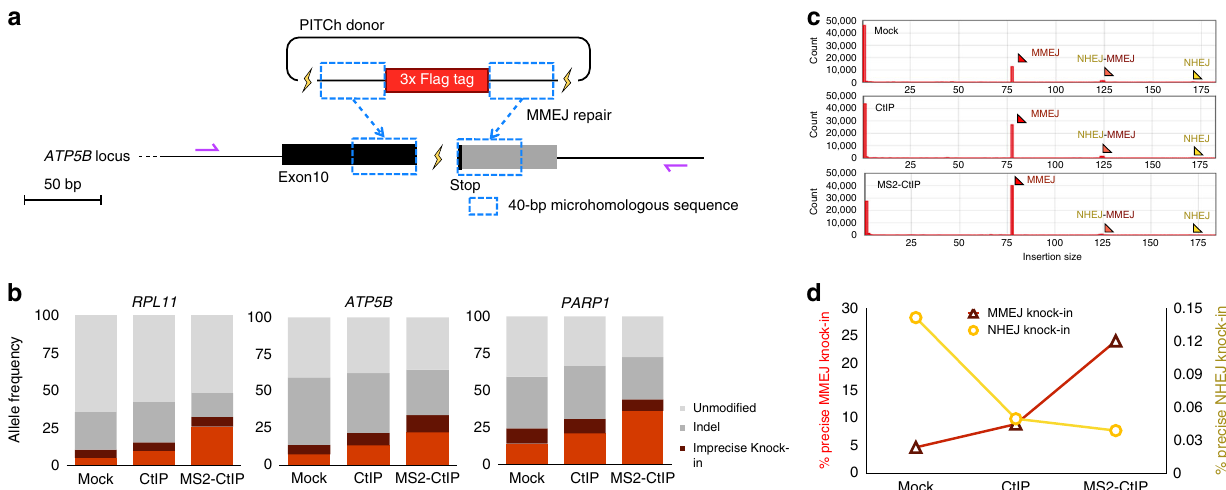
Fig. 2 High dependence on MMEJ in the enhanced PITCh knock-in. a Schematic of PITCh knock-in of a short tag for NGS analysis. An ~50-bp 3× Flag tag sequence was knocked-in, and then all the ampli fi ed products using the primers illustrated by purple arrows were analyzed. This schematic only shows gene targeting in the ATP5B locus, but other gene loci such as PARP1 and RPL11 were targeted in a similar way. b Summary of the frequency of the alleles detected by NGS analysis. Precise knock-in includes MMEJ-dependent knock-in alleles without mutations. For the details of data analysis, see Methods available in the online version of this paper. c Histograms of the read counts at the ATP5B locus, separated by the lengths of inserts. MMEJ, MMEJ/NHEJ, and NHEJ show the expected sizes of the inserts mediated by MMEJ at both knock-in junctions, NHEJ at one junction and MMEJ at the other, and NHEJ at both junctions, respectively, as illustrated in Supplementary Figure 11a. Similar results were obtained at the other two loci (Supplementary Fig. 11c). d Percentages of precise knock-in alleles mediated by MMEJ and NHEJ among total NGS reads at the RPL11 locus. Similar results were obtained at the other two loci (Supplementary Fig.